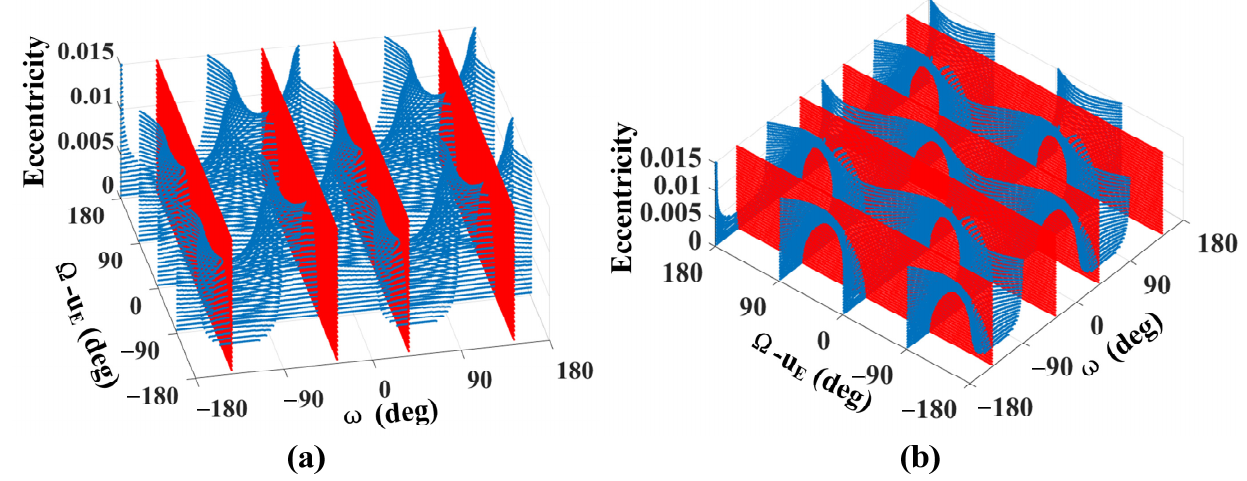
Figure 9. Distributions of DIZL and DWZL. Subplots ( a ) and ( b ) are two different viewpoints.